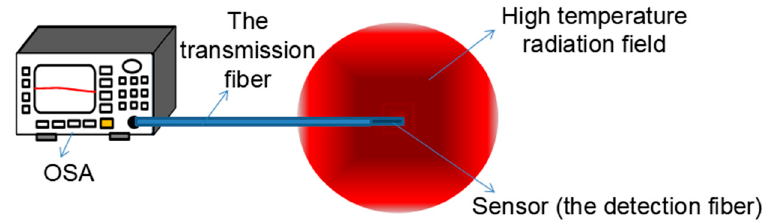
Figure 1. Schematic diagram of a optical fiber infrared radiation sensor.